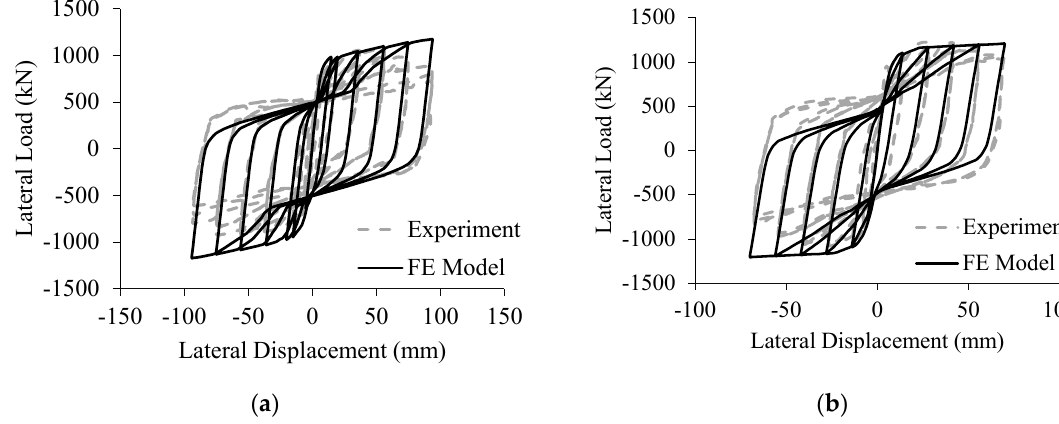
Figure 15. Validation of PERFORM-3D models in comparison to experimental results: load–displacement hysteresis curves of specimens ( a ) GSPCW-1 and ( b ) GSPCW-2.